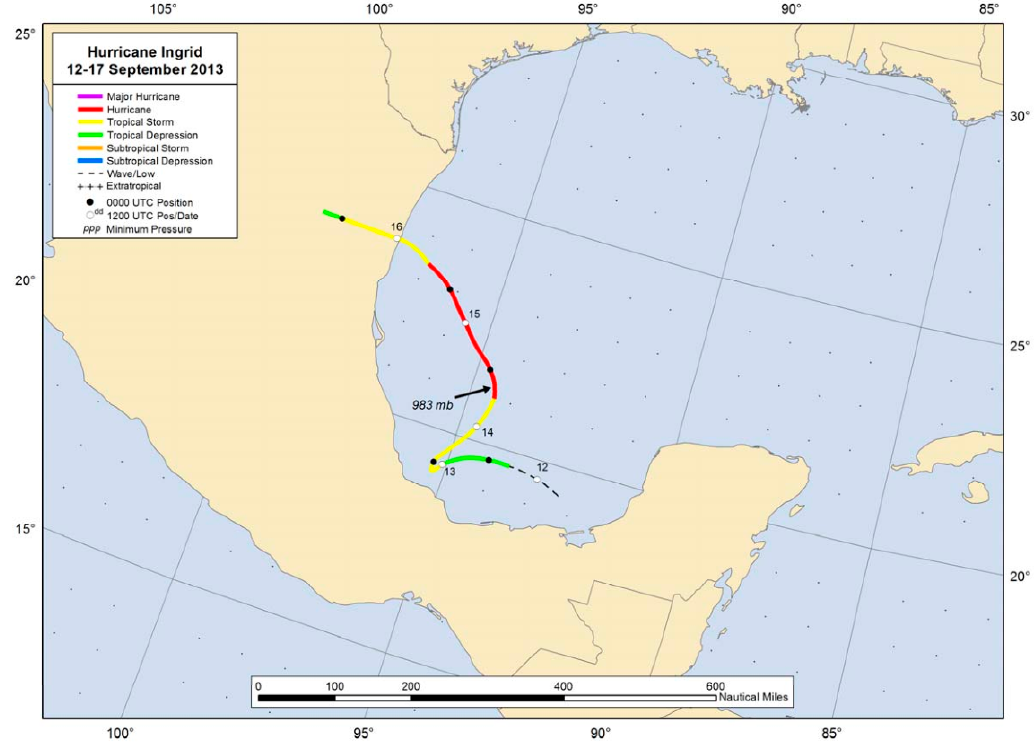
Figure 7. Best track positions for Hurricane Ingrid, 12–17 September 2013 [33], the directions of longitude and latitude are north and west.